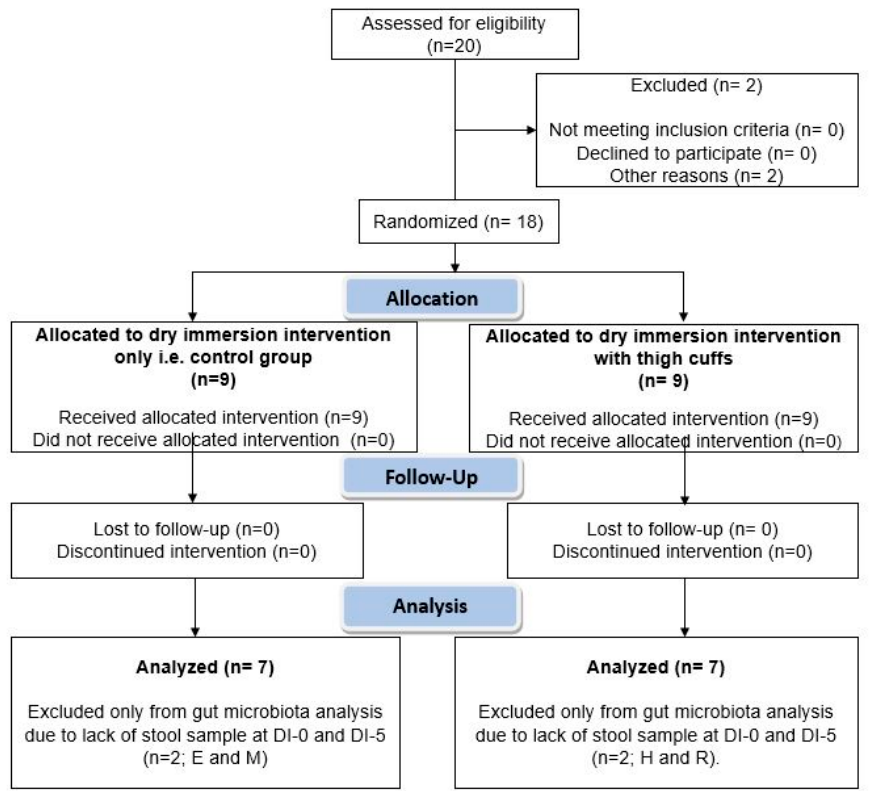
Figure 1. Participants’ flow chart. Twenty men were recruited to undergo dry immersion for 5 days. Before randomization, two participants were excluded. The remaining 18 men were divided in two groups: Control group ( n = 9) and Cuffs group (with thigh cuffs; n = 9). Stool samples were collected at DI-0 and DI-5 for gut microbiota analysis. DI-0 = before Dry Immersion initiation; DI-5 = day 5 of Dry Immersion.